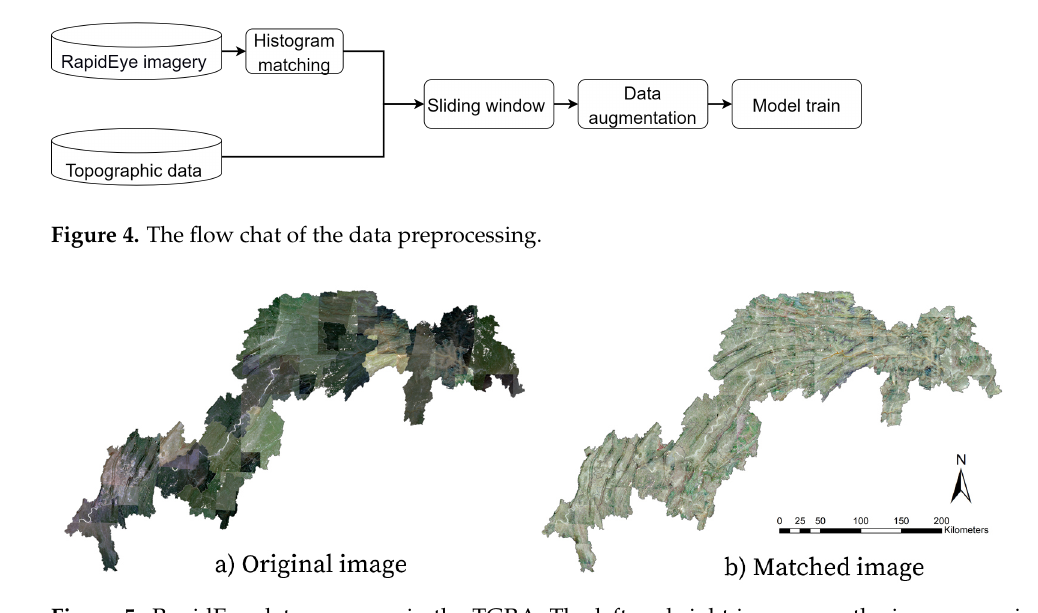
Figure 5. RapidEye data coverage in the TGRA. The left and right images are the image mosaic before and after histogram matching, respectively.